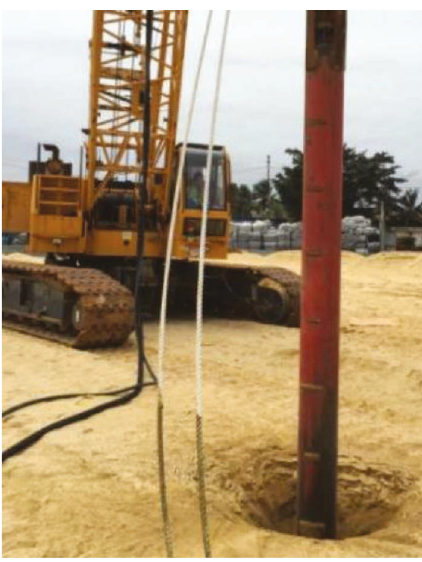
Figure 6: On-site